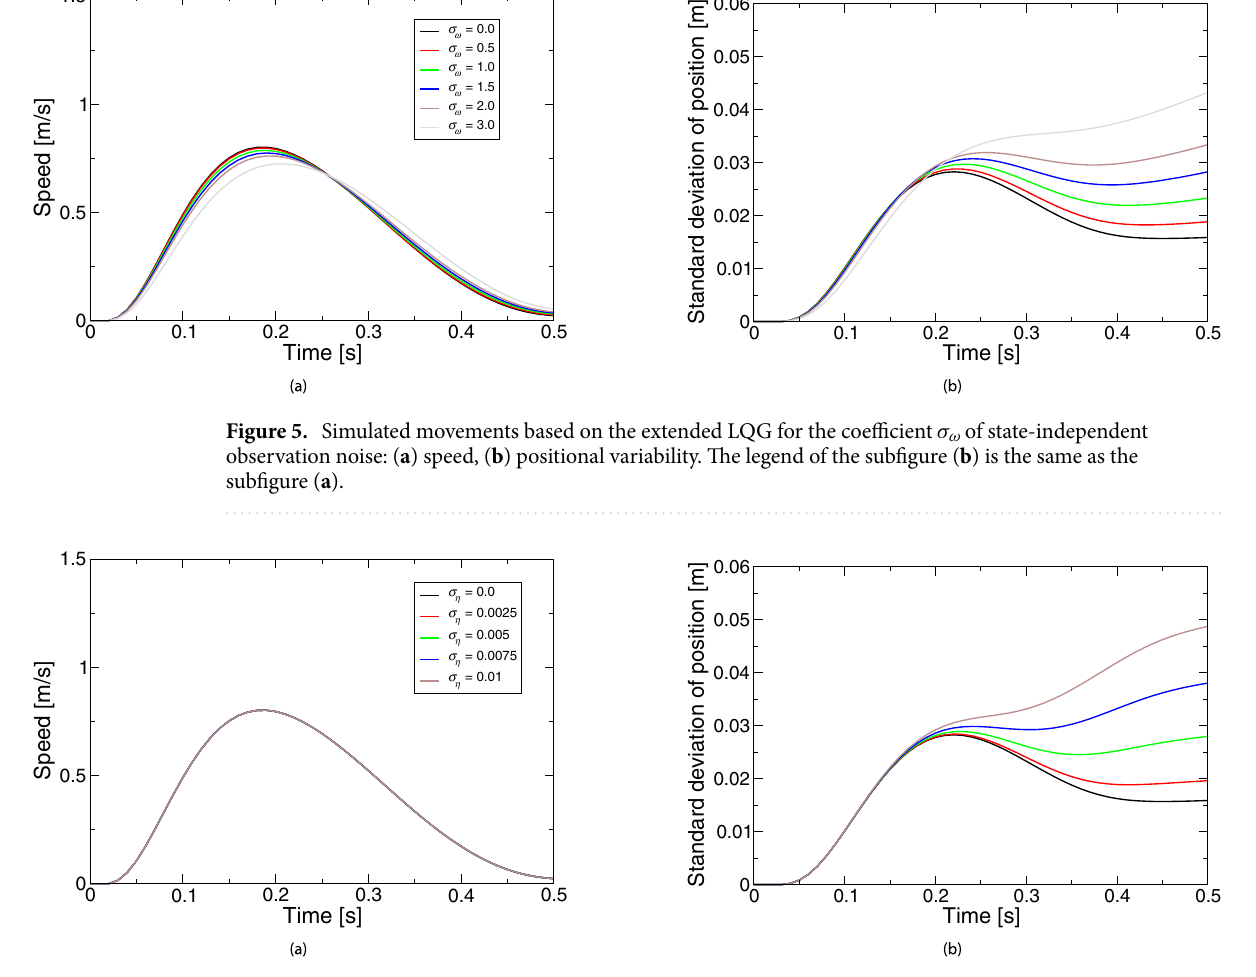
Figure 6. Simulated movements based on the extended LQG for the coefficient σ η of internal estimation noise: ( a ) speed, ( b ) positional variability. The legend of the subfigure ( b ) is the same as the subfigure ( a